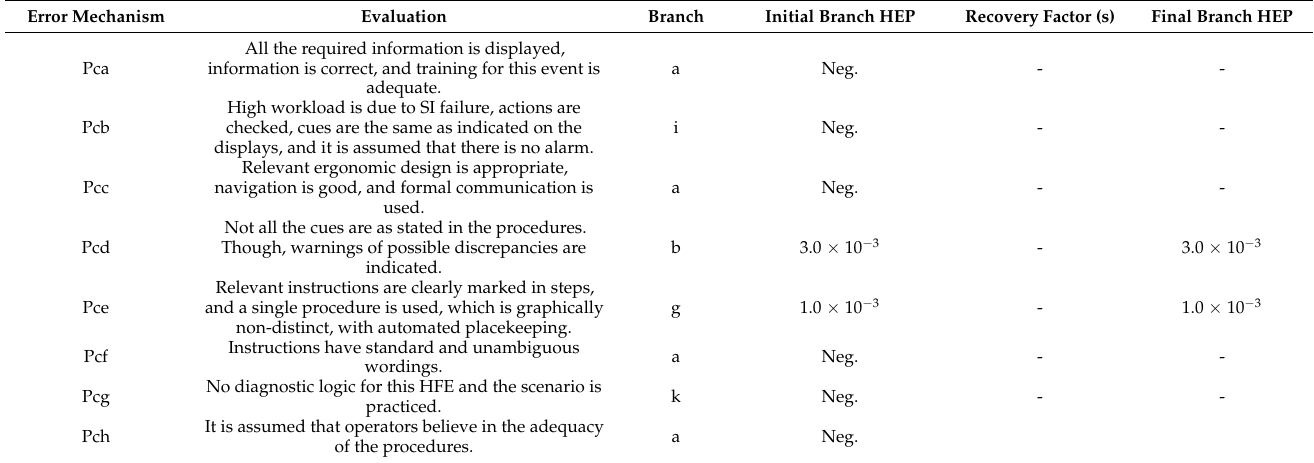
Table 11. Evaluating the diagnosis error for performing an aggressive secondary cooling for SLOCA. Error